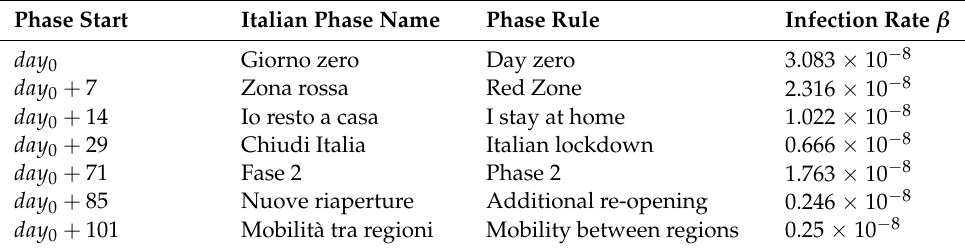
Table 1. Phases from day 0 February the 24th